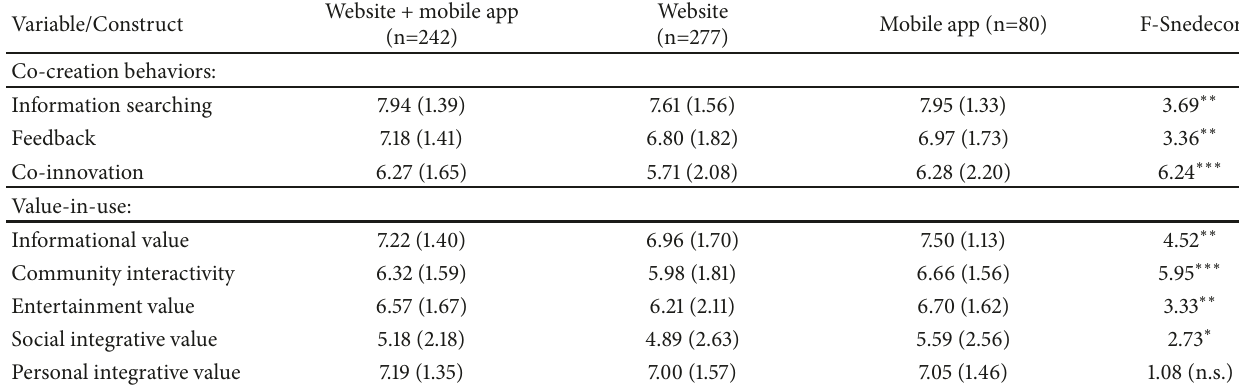
Table 1: Description of variables according to platform used to access the online travel